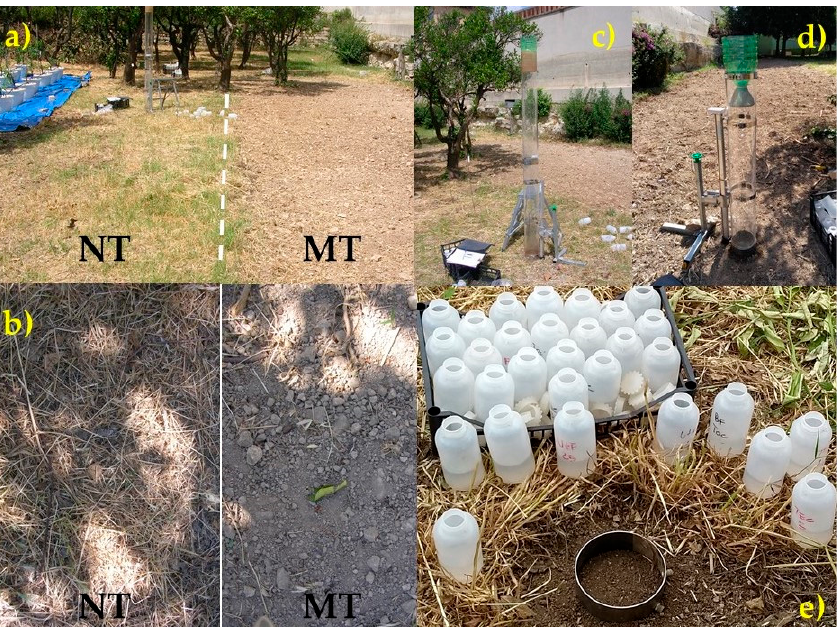
Figure 1. View of experimental field with indication of tilled (MT) and no-tilled (NT) plots ( a , b ), and the device used to ensure flow verticality and to prevent wind effects during the runs with a height of water pouring of 200 cm ( c ), 100 cm ( d ), and 3 cm ( e ).